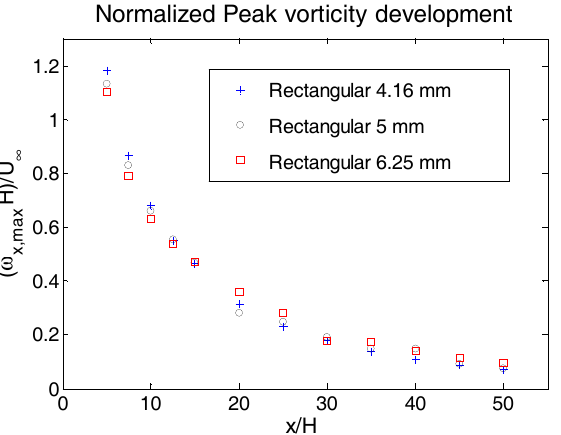
Figure 12. The normalized peak vorticity development for the different VG heights.